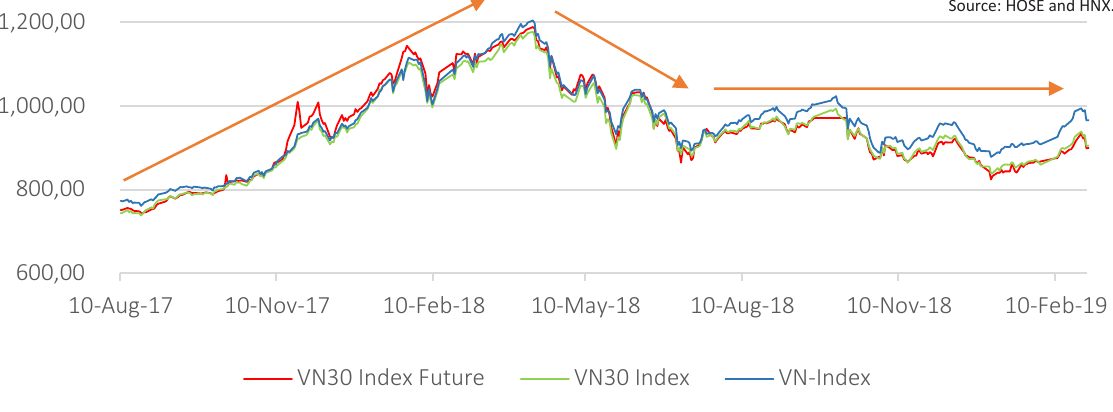
Figure 2. Price movements of VN Index, VN 30 Index, and VN 30 Index Futures